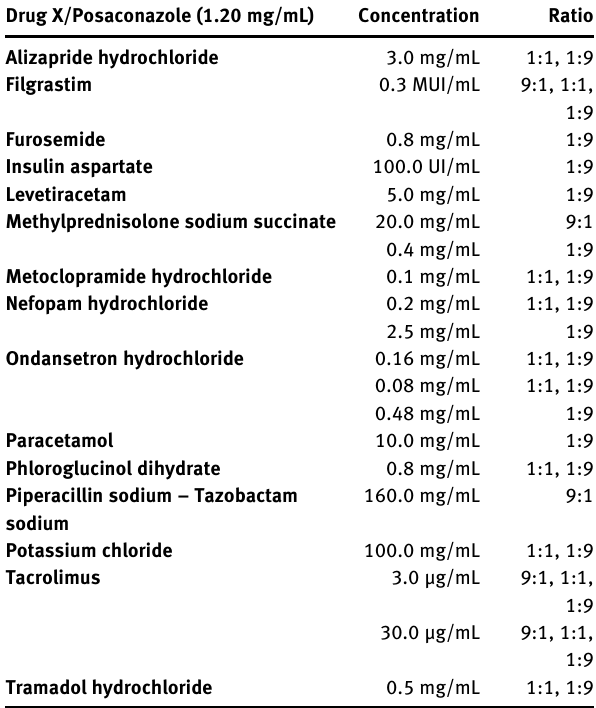
Table  : Final ratio results without physical modi fi cation after  -h storage. Drug X/Posaconazole (  .  mg/mL) Concentration